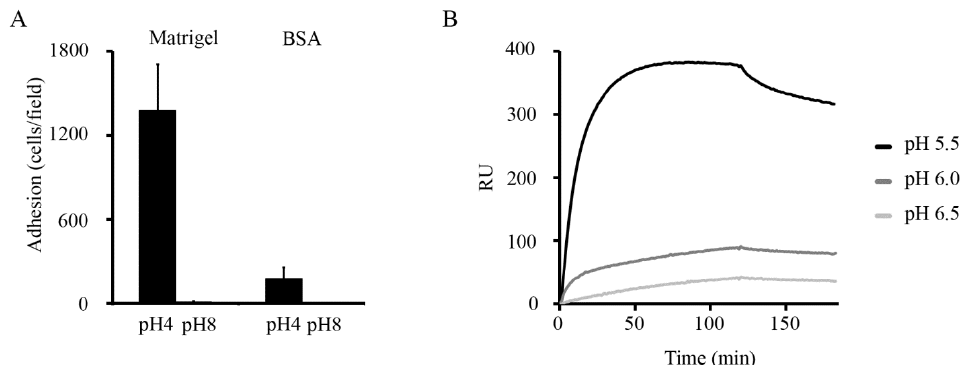
Figure 1. Adherence of L. crispatus ST1 and binding of His -GS of ST1 are affected by pH. 6 ( A ) Adherence of L. crispatus ST1 at pH 4 and pH 8 to the immobilized basement membrane preparation Matrigel and to BSA. Prior to the assays, the bacteria from an overnight culture were washed with the pH 4 or the pH 8 buffer, and the adhesion assays were performed at the corresponding pH. Means of adherent bacteria in 20 randomly chosen microscopic fields of 1.6 × 10 4 μm 2 and standard deviations are shown. ( B ) Binding of purified His -GS to immobilized laminin was tested by surface plasmon resonance at 6